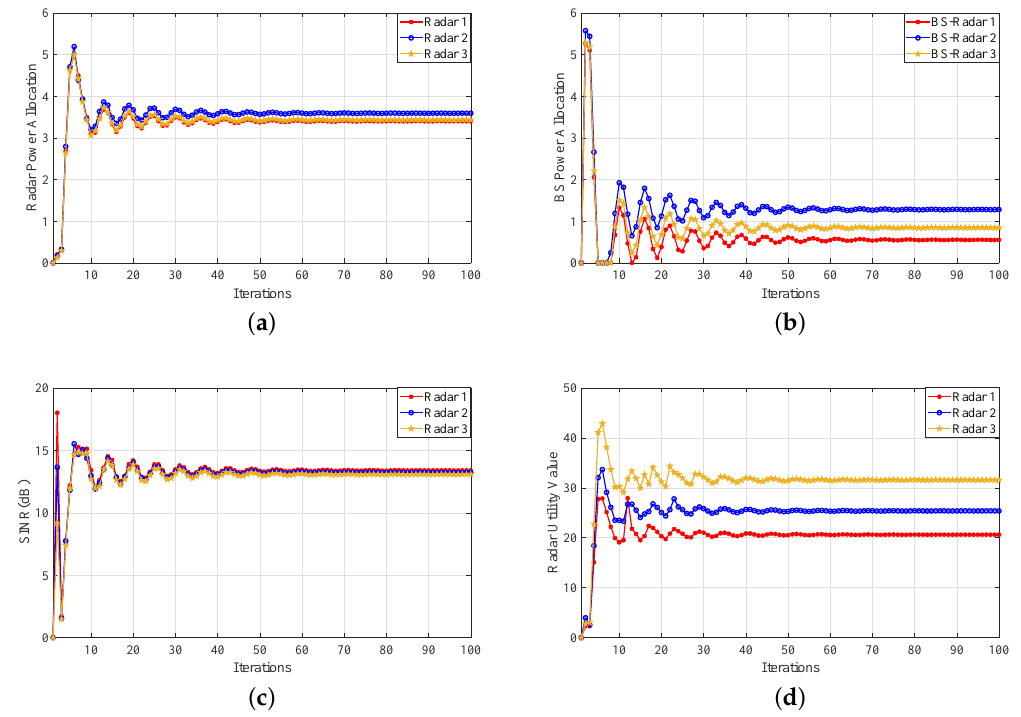
Figure 3. Supermodular PAG algorithm. ( a ) Power allocation convergence for multistatic MIMO radar. ( b ) Power allocation convergence for base station (BS). ( c ) Signal to interference noise ratio (SINR) convergence for multistatic MIMO radar. ( d ) Utility value convergence for multistatic MIMO